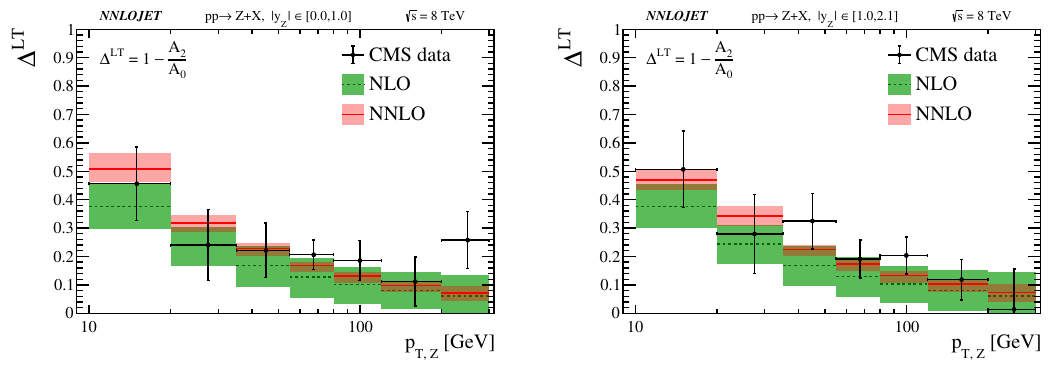
Figure 13 . The extent of the Lam-Tung violation as expressed through (cid:1) LT for the CMS data in p pp collisions at s = 8 TeV, with the kinematic cuts of j y Z j 2 [1 : 0 ; 2 : 1] (left) and j y Z j 2 [1 : 0 ; 2 : 1] (right). The data is compared to the corresponding NLO (green (cid:12)ll) and NNLO (red (cid:12)ll)